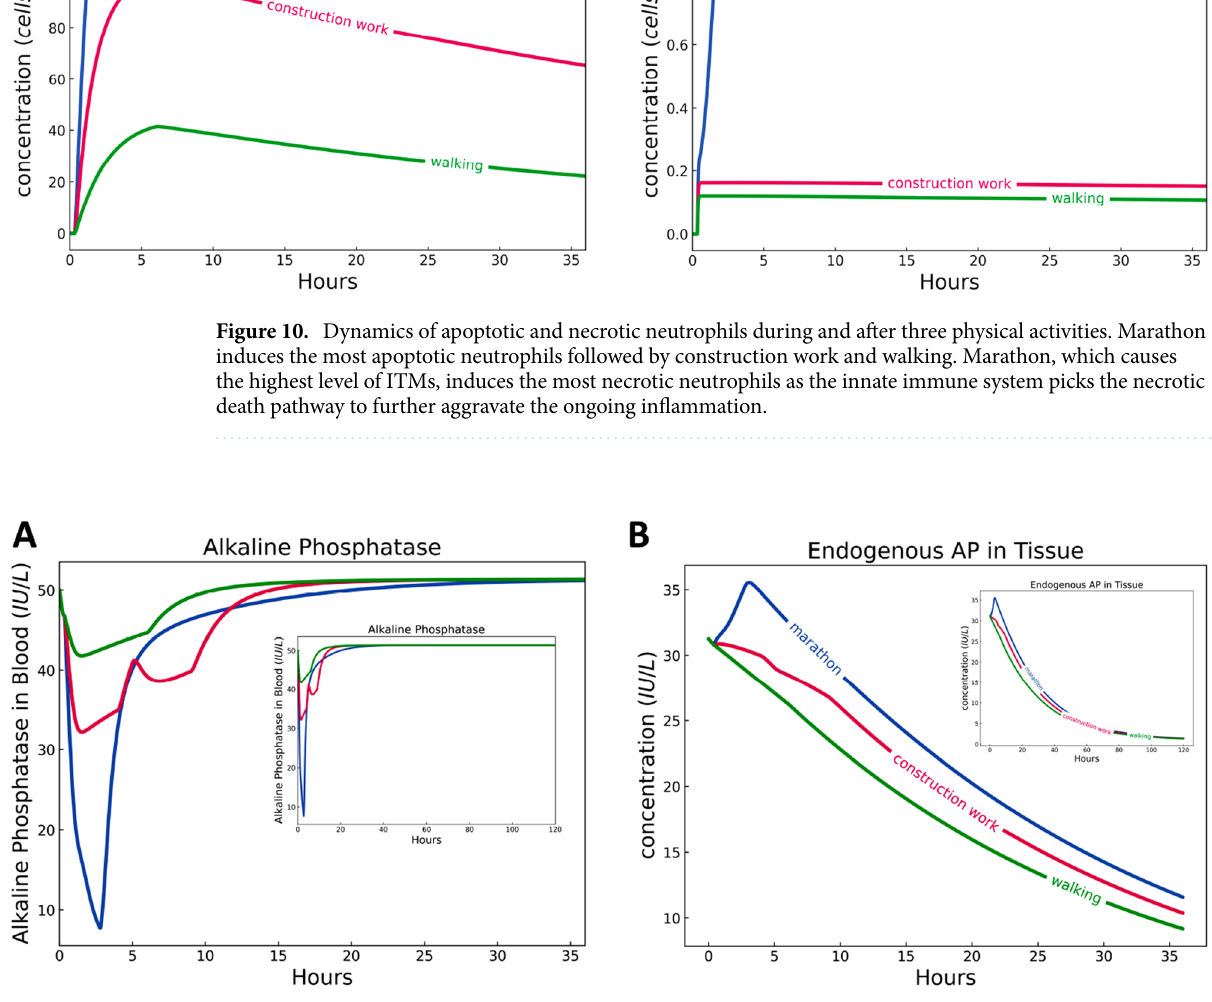
Figure 11. Dynamics of alkaline phosphatase in blood (A) and tissue (B) during and after three physical activities. simulated for 36 h/1.5 days (main) and 120 h/5 days (snippet). Marathon induces the highest level of alkaline phosphatase in tissue, followed by construction work and walking. Alkaline phosphatase is known to neutralise inflammation, hence, the more intense the inflammation is, the stronger it is